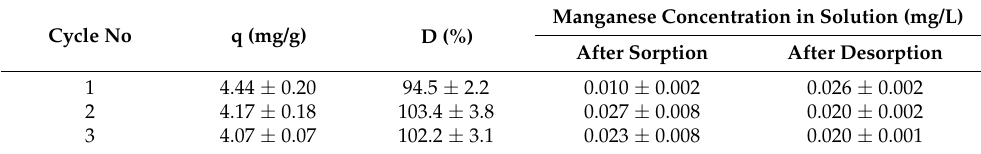
Table 4. Sorption and desorption efficiency of the Mn-biosorbent hydrogel